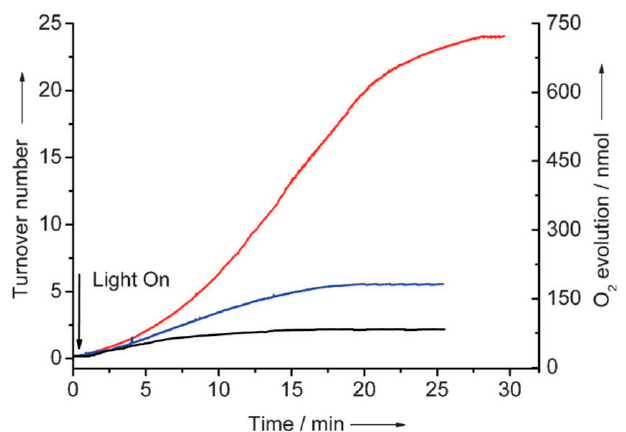
Figure 6. Accumulations of the oxygen in the course of water oxidation catalyzed by assemblies {Co 4 O 4 (OAc) 3 (Py) 4 }{(L 7 )Ru(bpy) 2 } (20a , blue line) and {Co 4 O 4 (OAc) 2 (Py) 4 } 2 {(L 8 )Ru(bpy) 2 } 2 ( 21 , red line), as well as the equimolar mixture of [Co 4 O 4 (OAc) 3 (Py) 4 ] and [Ru(bpy) 3 ]Cl 2 ( 20b , black line). Complex [Co 4 O 4 (OAc) 3 (Py) 4 ] is equivalent to 9 . Adapted with permission from [61],Wiley, 2014.